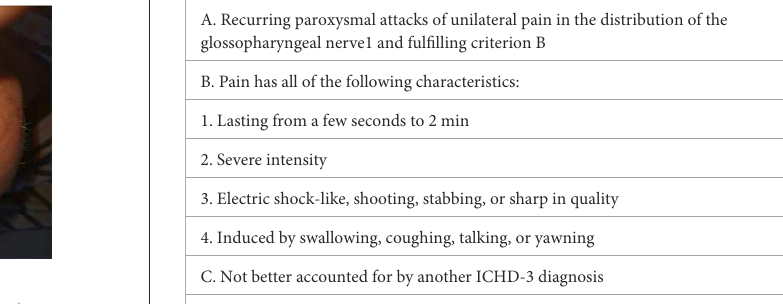
TABLE 2 Diagnostic criteria of glossopharyngeal